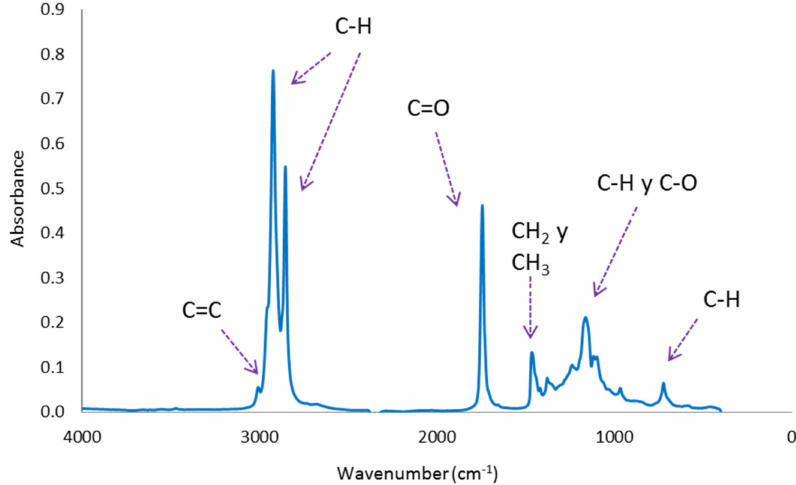
Figure A1. Example of MIR spectrum of the fat extracted from meat (Holstein bulls) with the characteristic peaks and the assignment with chemical functional